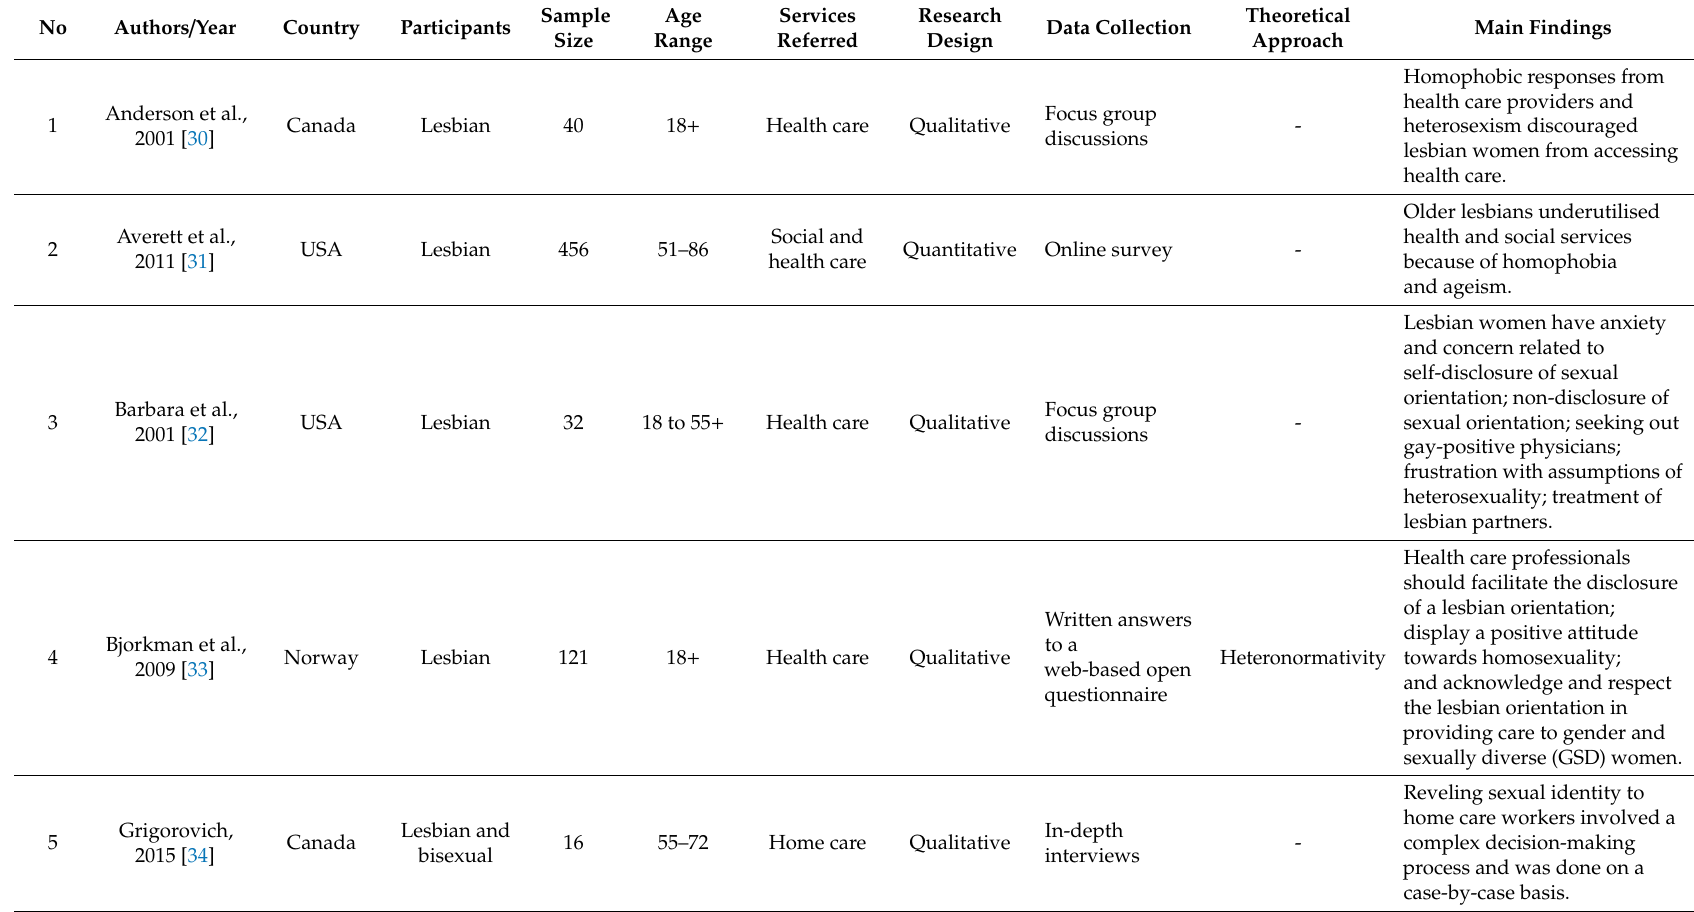
Table 2. A comparison of demographic and methodological characteristics of individual studies included in the systematic